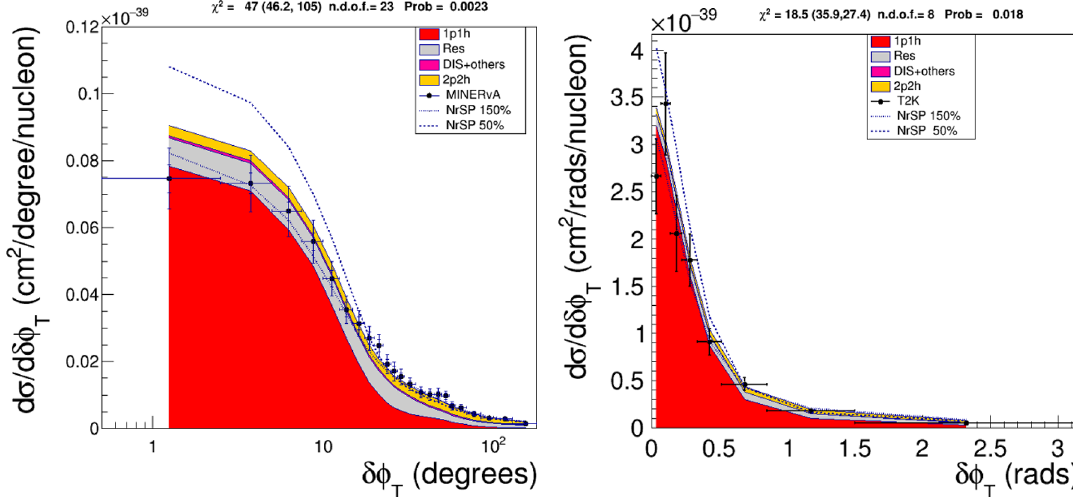
Figure 9 . CC 0 π 1 p MINERvA [15, 19, 20] (left) and T2K [21] (right) distributions for the TKI angular variable δφ . Details of the comparison with NEUT results as in figure T